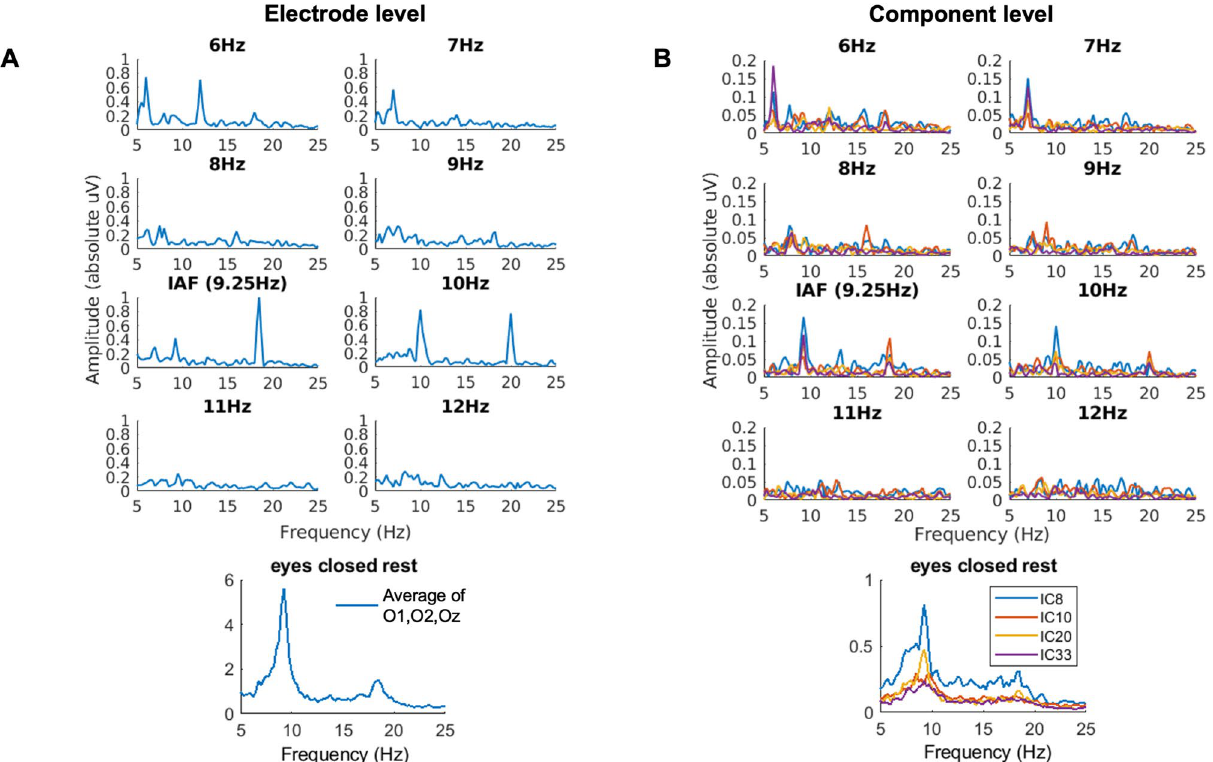
Figure 5. Electrode versus component level power spectra for one subject. (Panel A ). Electrode level. The average FFT-derived power spectrum across electrodes O1, O2 and Oz are shown for each rhythmic flicker frequency condition and the eyes closed rest condition. (Panel B ). Component level. The FFT-derived power spectra for each of the four components for this subject are shown for each of the rhythmic flicker frequency conditions and the eyes closed rest